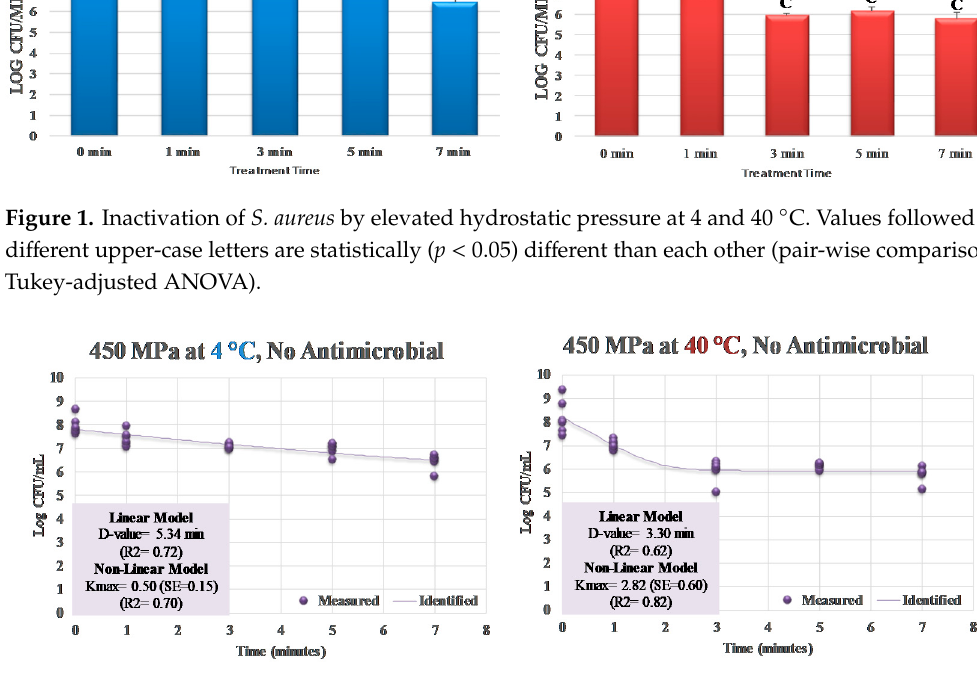
Figure 2. Linear and non-linear inactivation indices for inactivation of S. aureus treated by elevated hydrostatic pressure at 450 MPa at 4 and 40 °C with no bacteriocin or bactericidal compound. Measured = Actual observations; Identified = Best-fitted non-linear model.